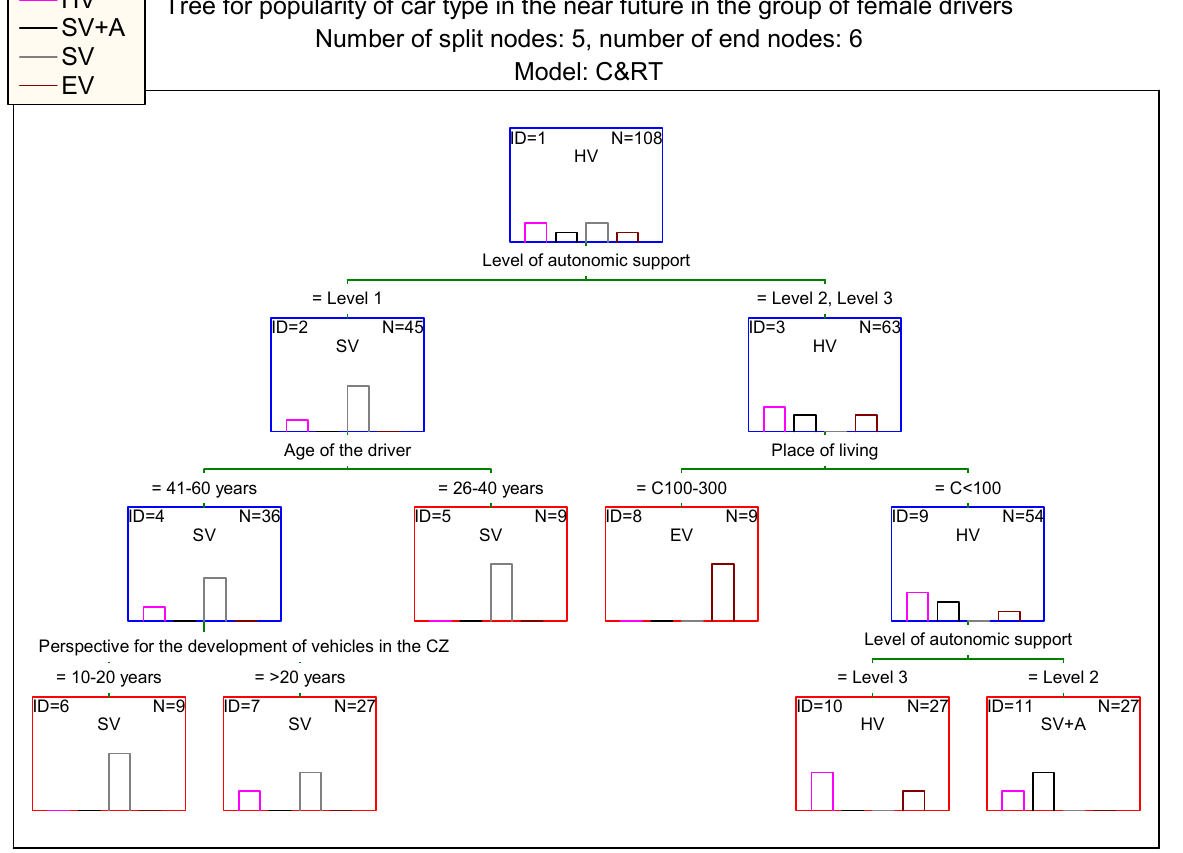
Figure 6. C&RT classification tree for the dependence of the popularity of individual types of systems used in passenger cars in the opinion of women on such dependent variables as the level of vehicle autonomy, age of the driver, place of residence and the time when these cars will be popular in the future.